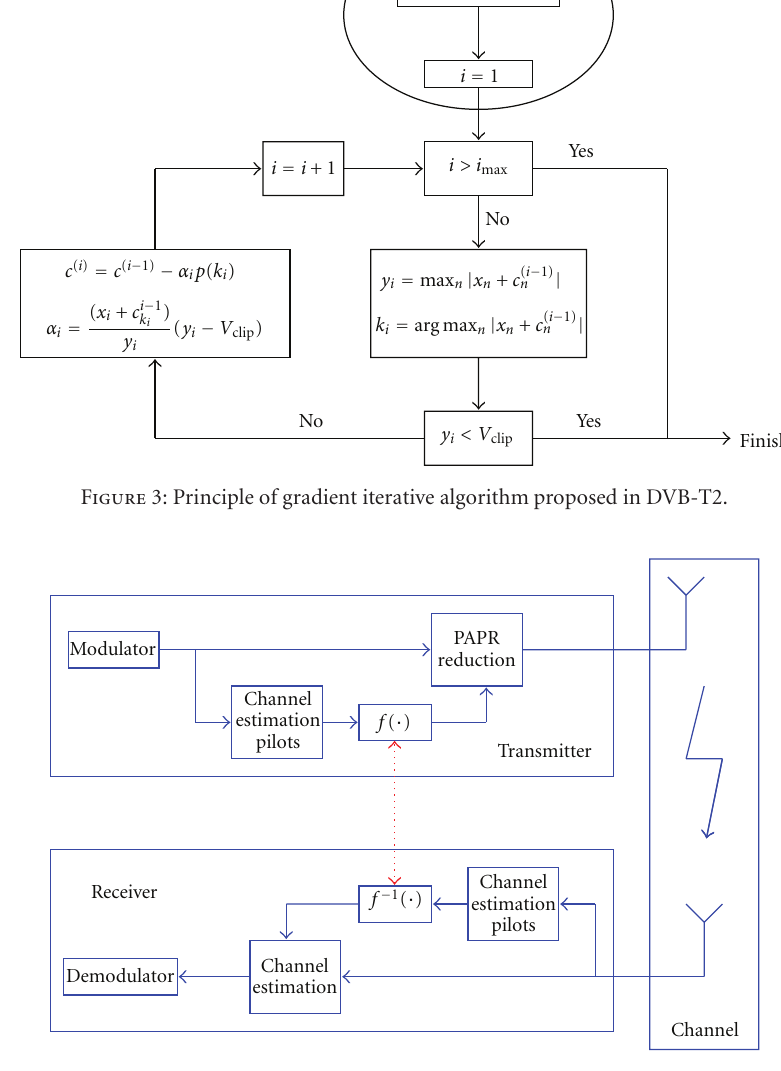
Figure 4: General principle of the proposed